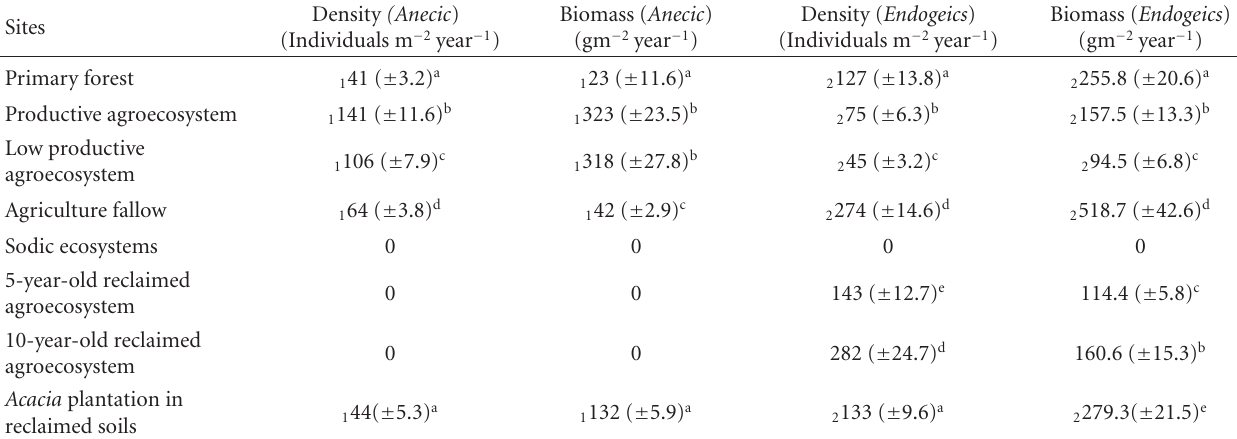
Table 2: E ff ect of land conversion and management practices on changes in functional catagories of earthworms in the Indo-Gangetic plains, ( ± SE, n =